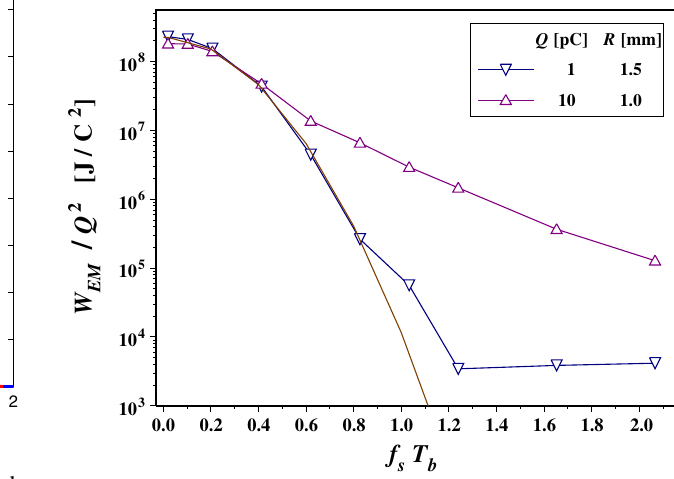
(cid:4) 1 ps ). The FIG. 4. (Color) Normalized total energy flux W b radiant emission emitted by a short electron bunch, as a function T of f s b